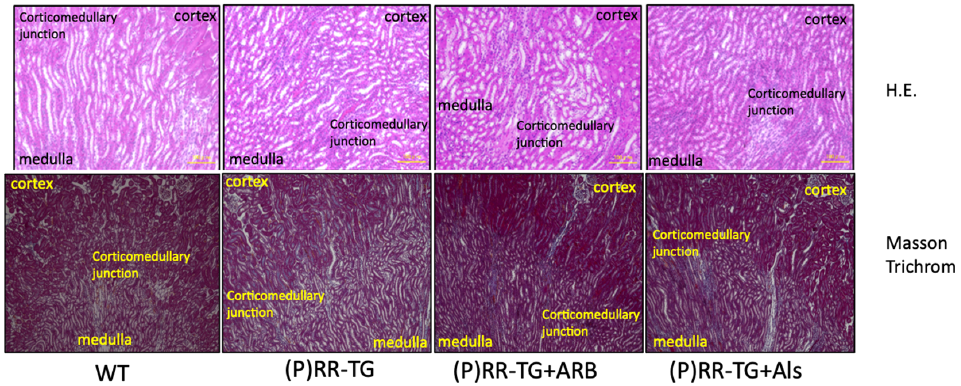
Figure 1. Histopathological findings using HE ( above ) and Masson trichrome ( below ) staining with X100 magnification by BZ-9000 (Keyence, Osaka, Japan).